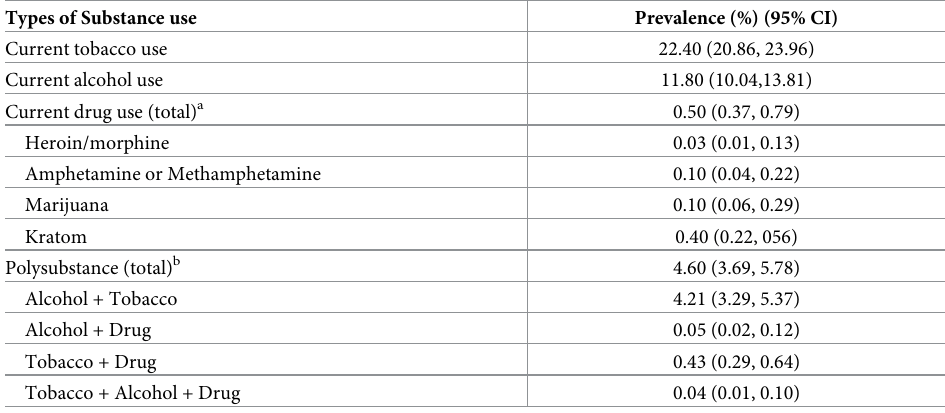
Table 2. Prevalence of substance use among adults in Malaysia aged 18 years and above (n = 10,472).